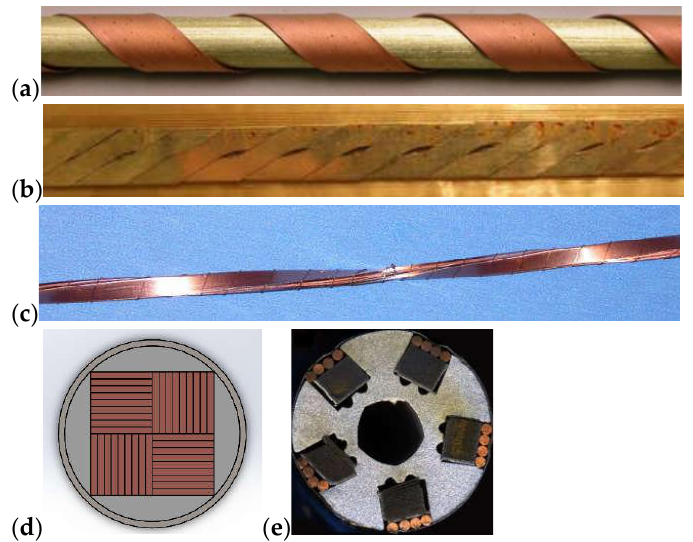
Figure 5. Diagram of the cables. ( a ) CORC; ( b ) Roebel; ( c ) TSTC; ( d ) Quasi-isotropic HTS strands;